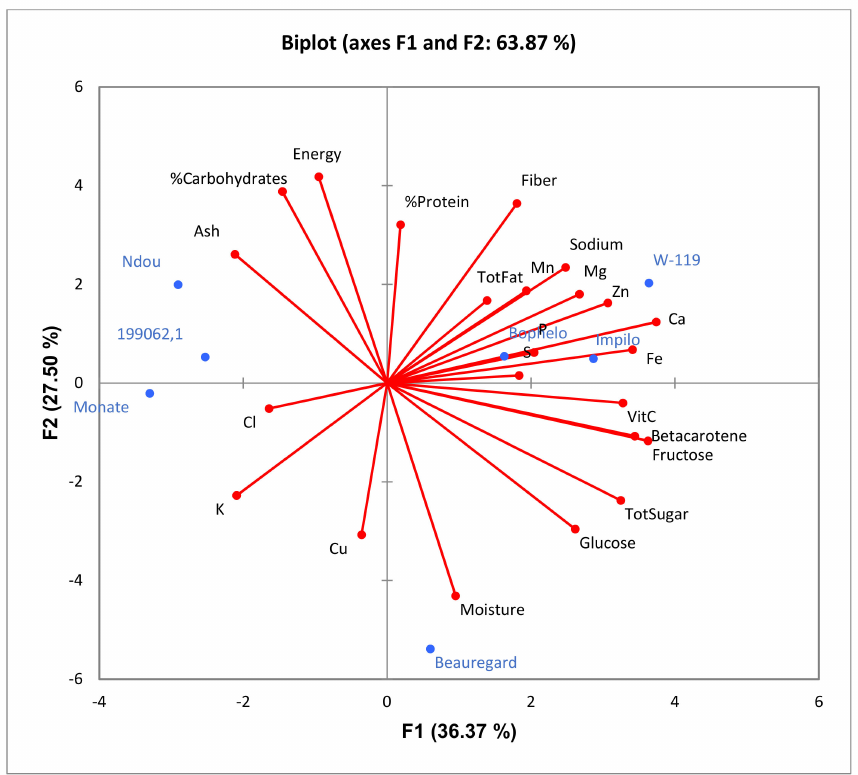
Figure 1. Biplot of the principal component analysis of all compositional parameters determined in seven sweet potato